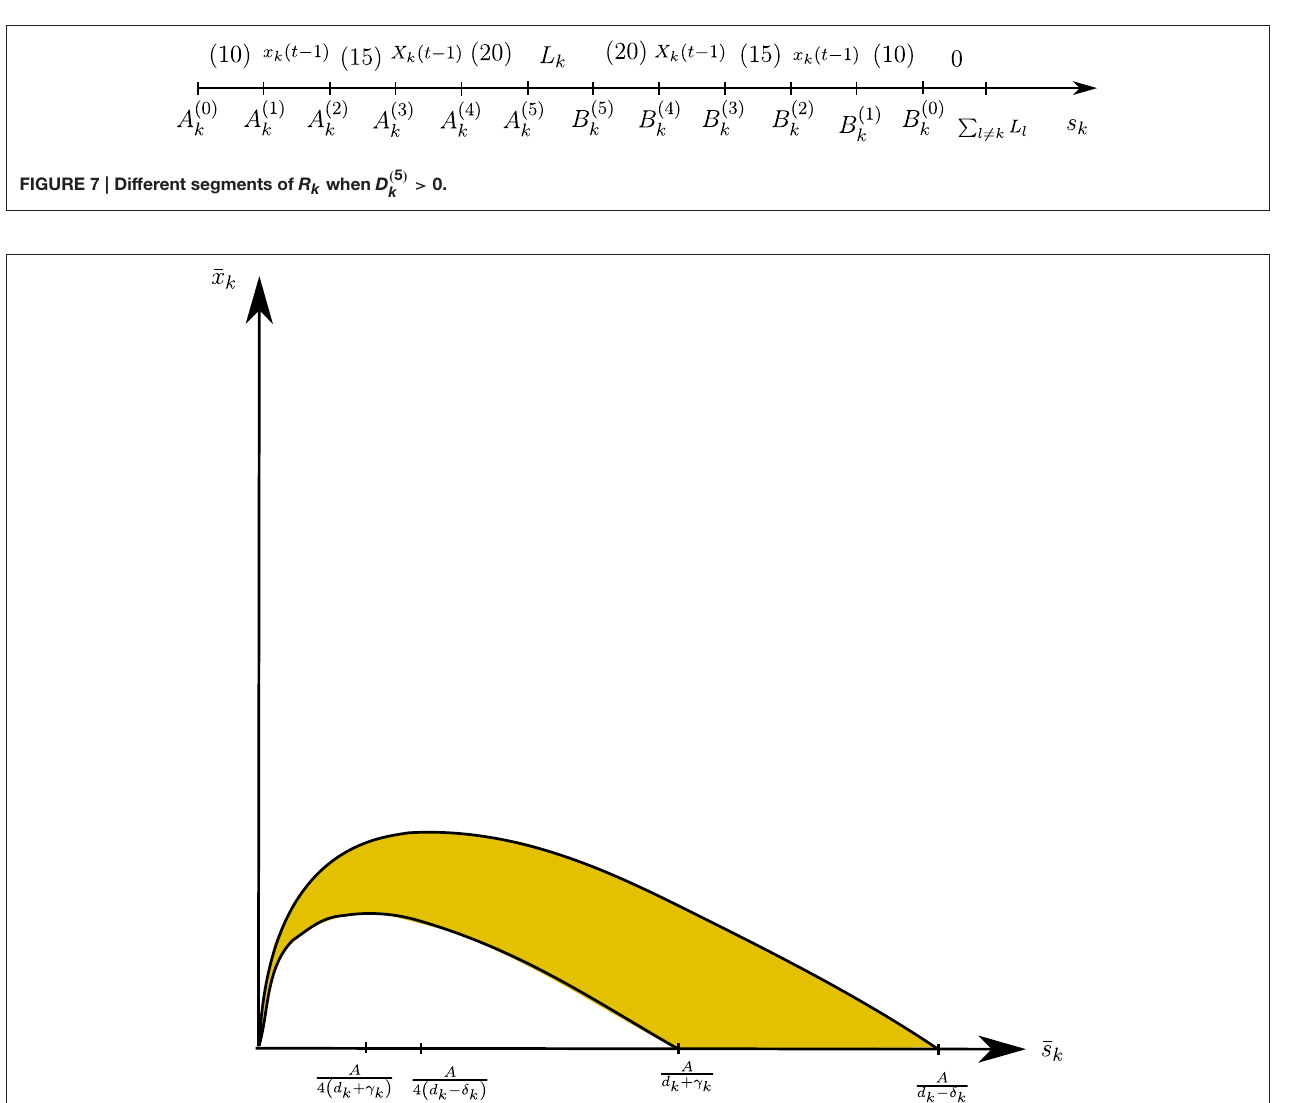
FIGURE 6 | Different segments of R k when D ( 5 ) k ≤ 0 and D ( 4 ) k > 0.